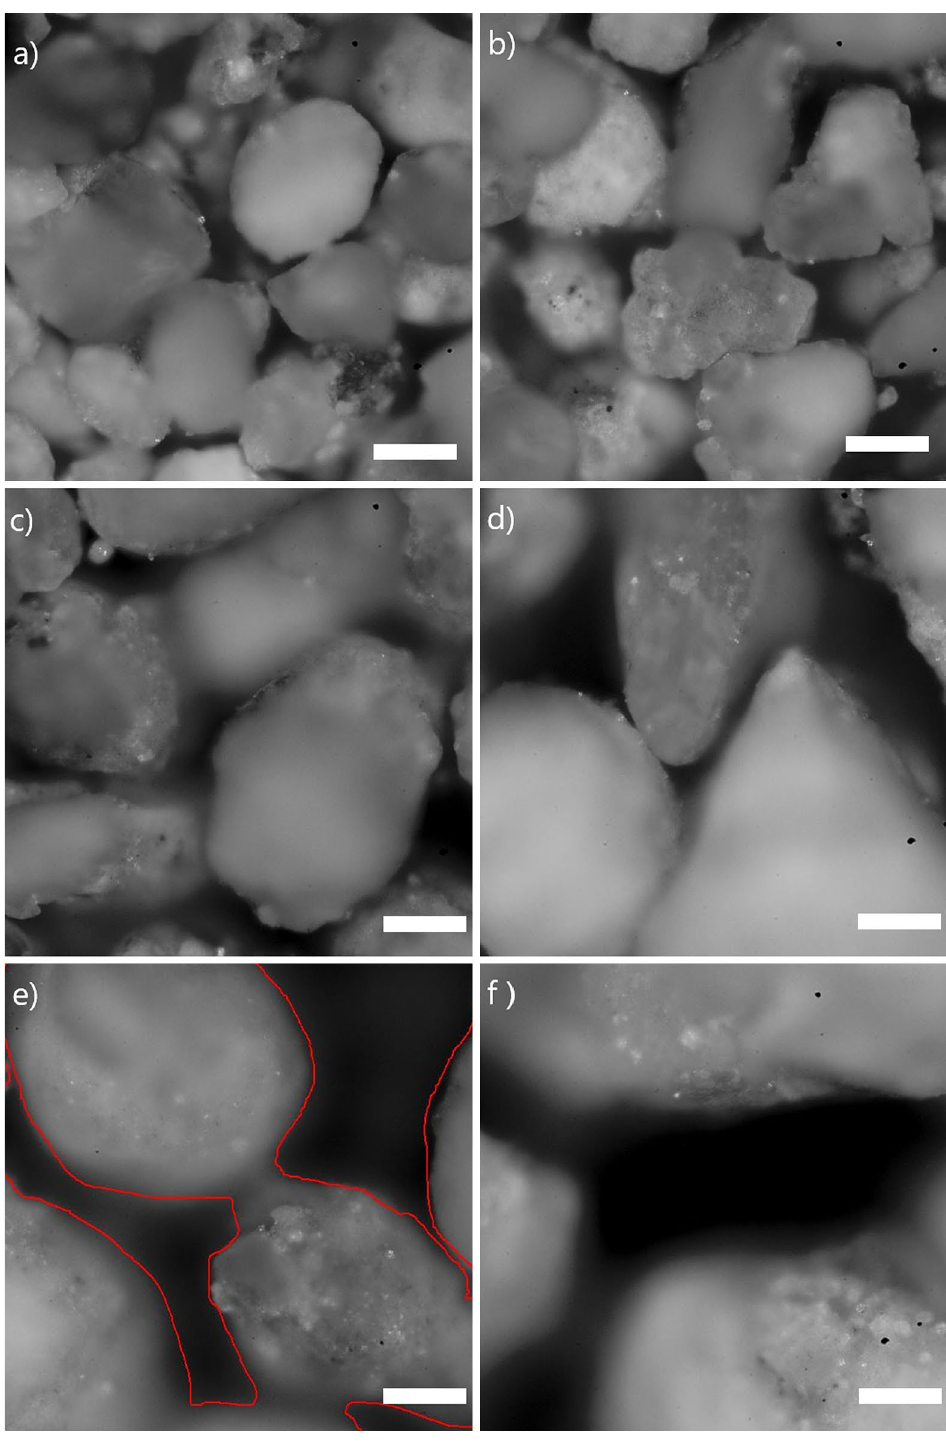
Figure 4. Microscopic images of the sample’s surface. ( a ) Particle size of 160 µm, ( b ) particle size of 200 µm, ( c ) particle size of 250 µm, ( d ) particle size of 300 µm, ( e ) particle size of 425 µm, ( f ) particle size of 500 µm. Scale bar in each figure represents 100